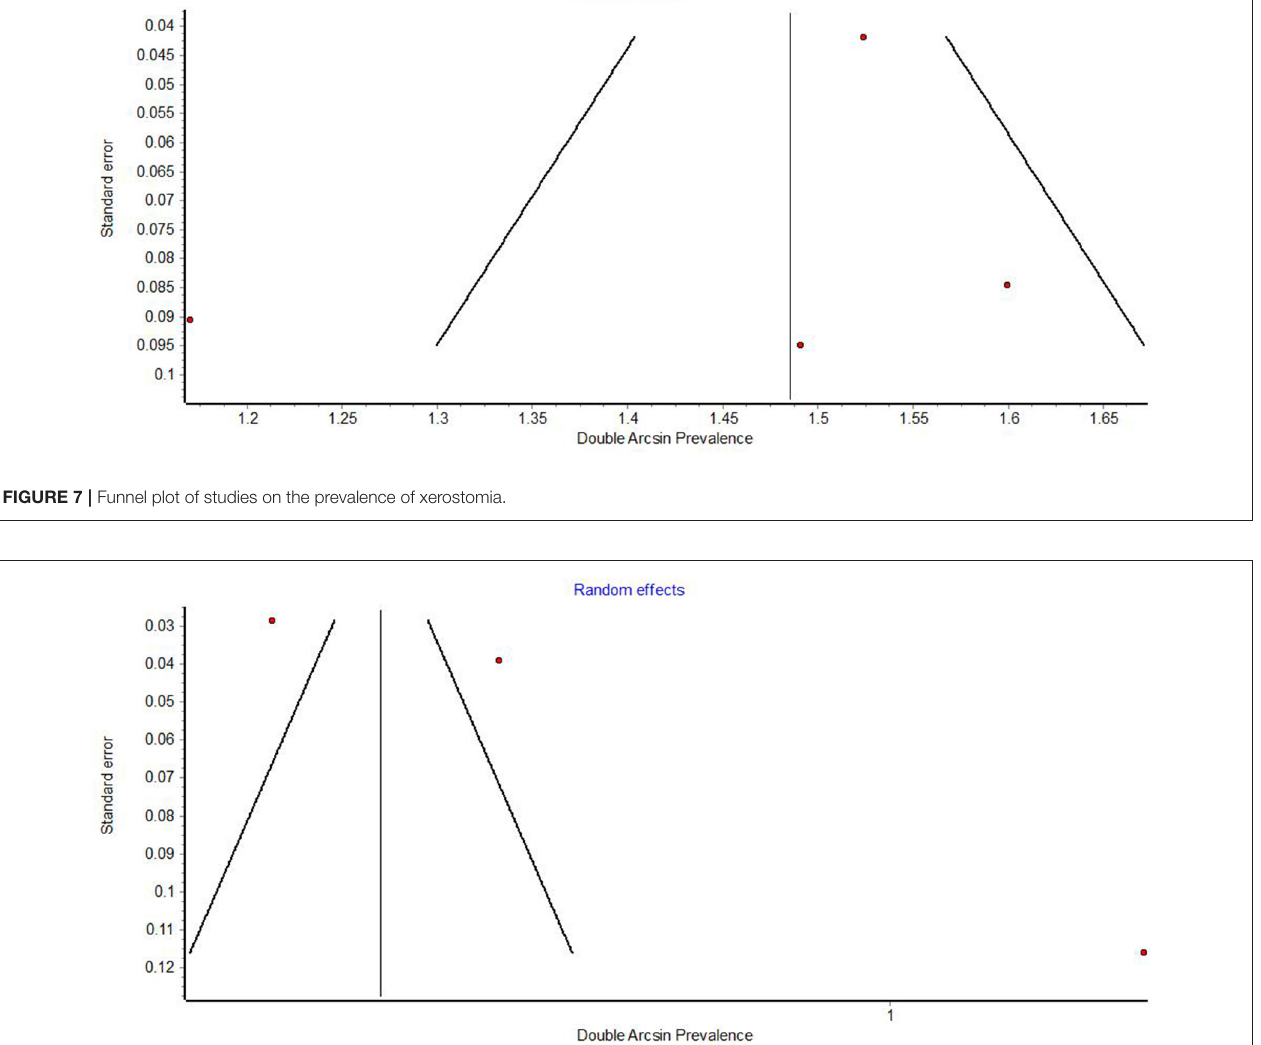
for oral lesions in general and 0.10 (95% CI = 0.01–0.24) for aphthous